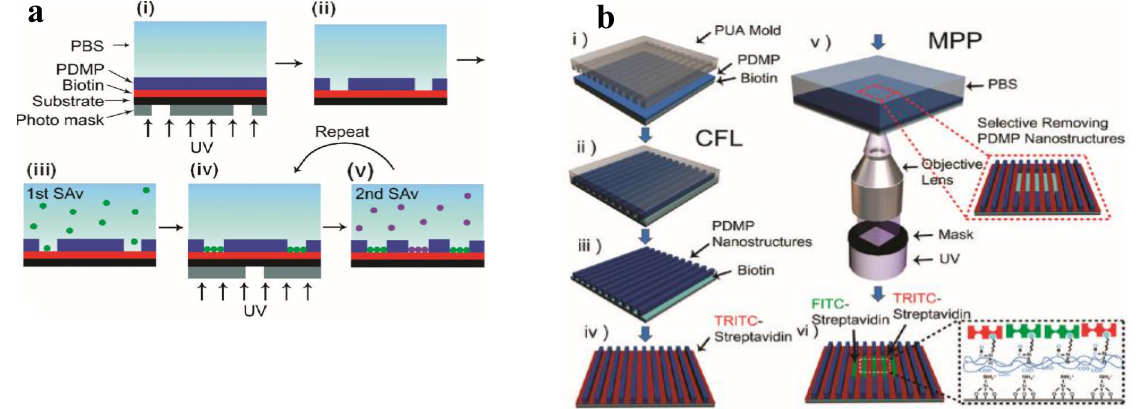
Figure 4. ( a ) Schematic of multiple streptavidin (SAv) patterning (Reprinted with the permission from reference [80] Copyright 2010 American Chemical Society). ( b ) Schematic diagram of the sequential fabrication of multiscale, multicomponent protein-patterned surfaces by combining CFL and MPP (Reprinted with the permission from reference [81] Copyright 2011 American Chemical